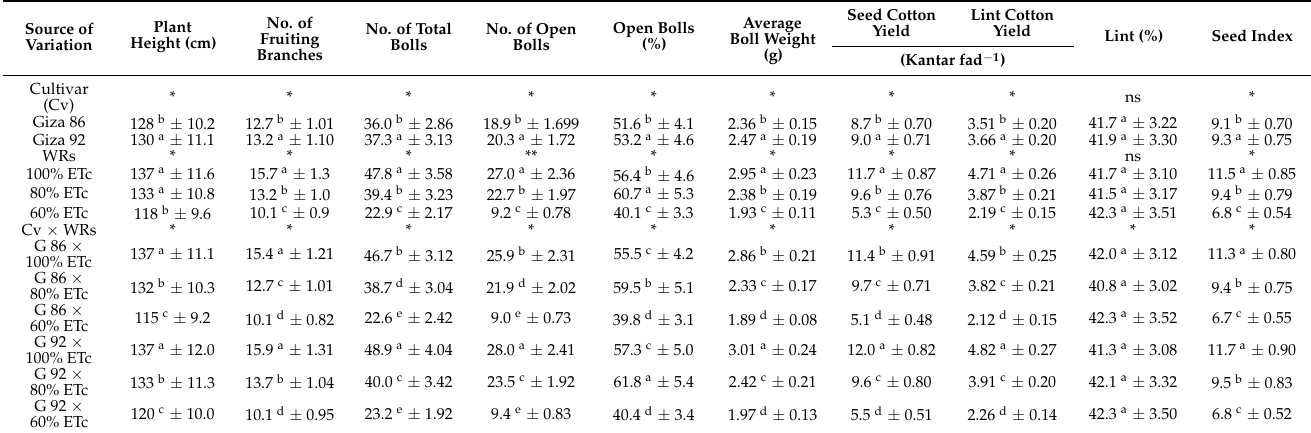
Table 4. Growth, yield, and yield attributes of cotton (cv. Giza 86 and 92) under different water regimes (WRs) on sandy soil. All values are the average of the 2019 and 2020 seasons.